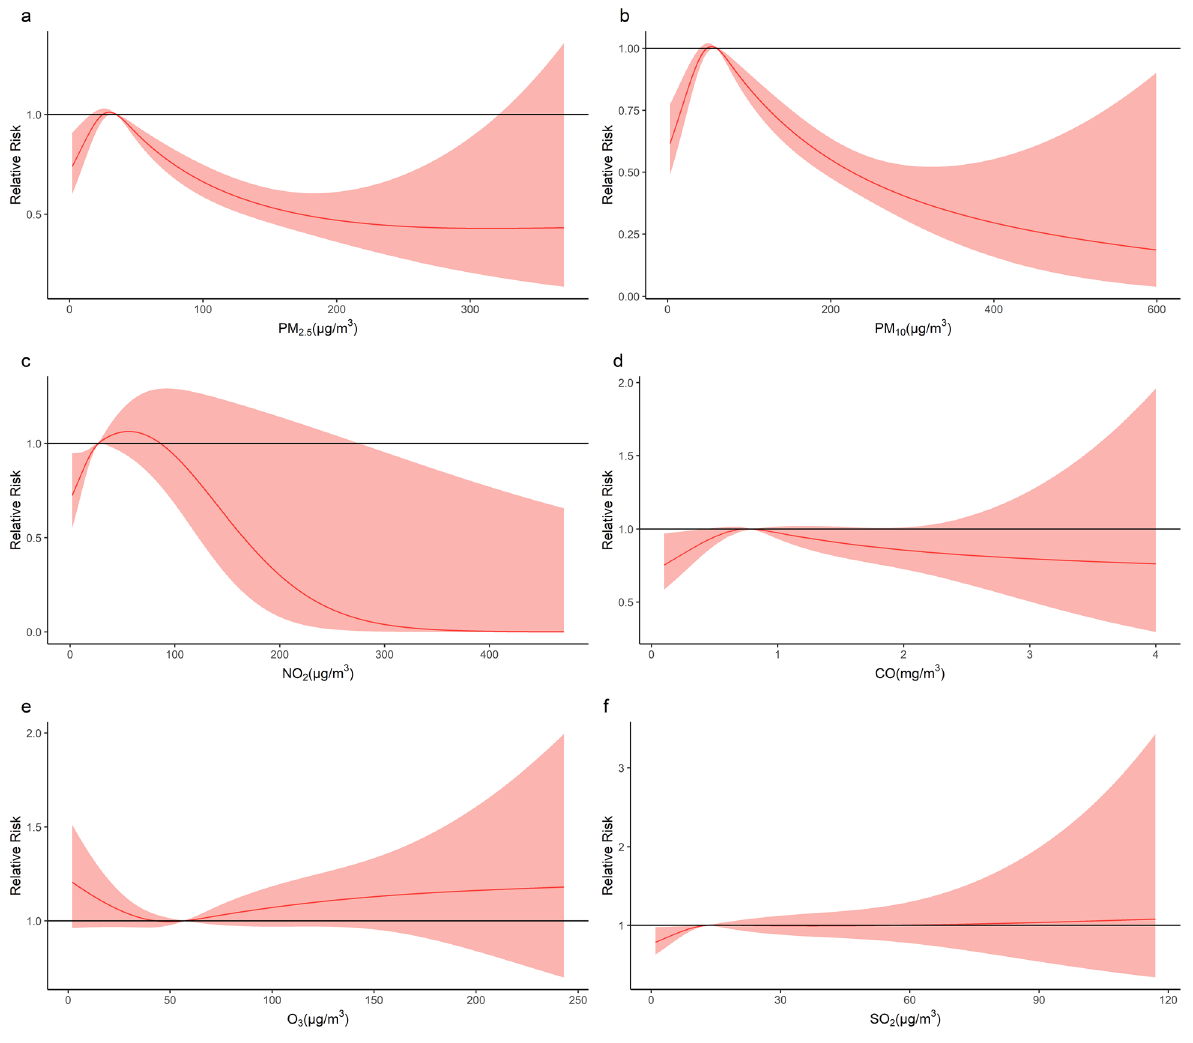
Figure 4. Cumulative associations of air pollutants with